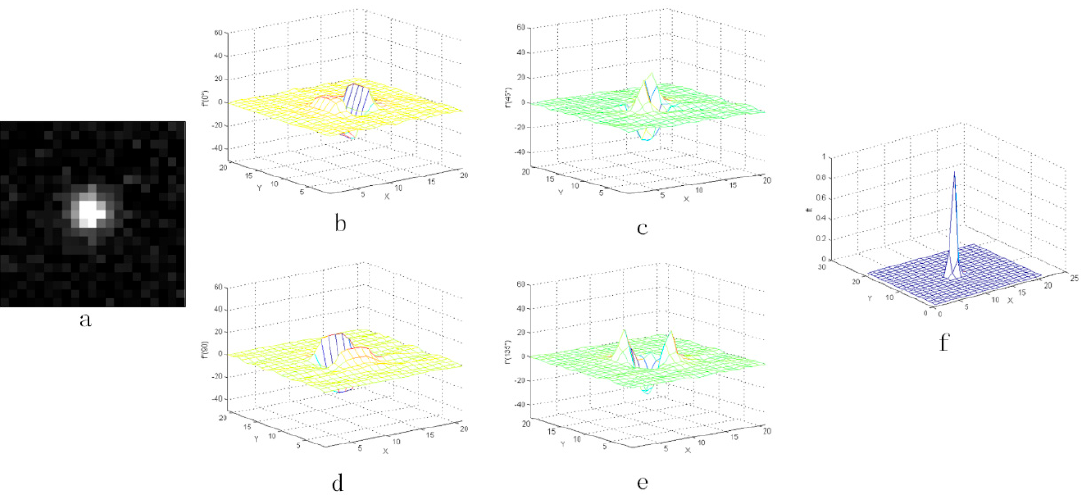
Figure 8. The result with the noise whose coefficient Q is 1%: ( a ) the star image with added random noise and ( b – e ) the three-dimensional distribution of the second-order derivative, ( f ) the output value f t after CMLCM processing.